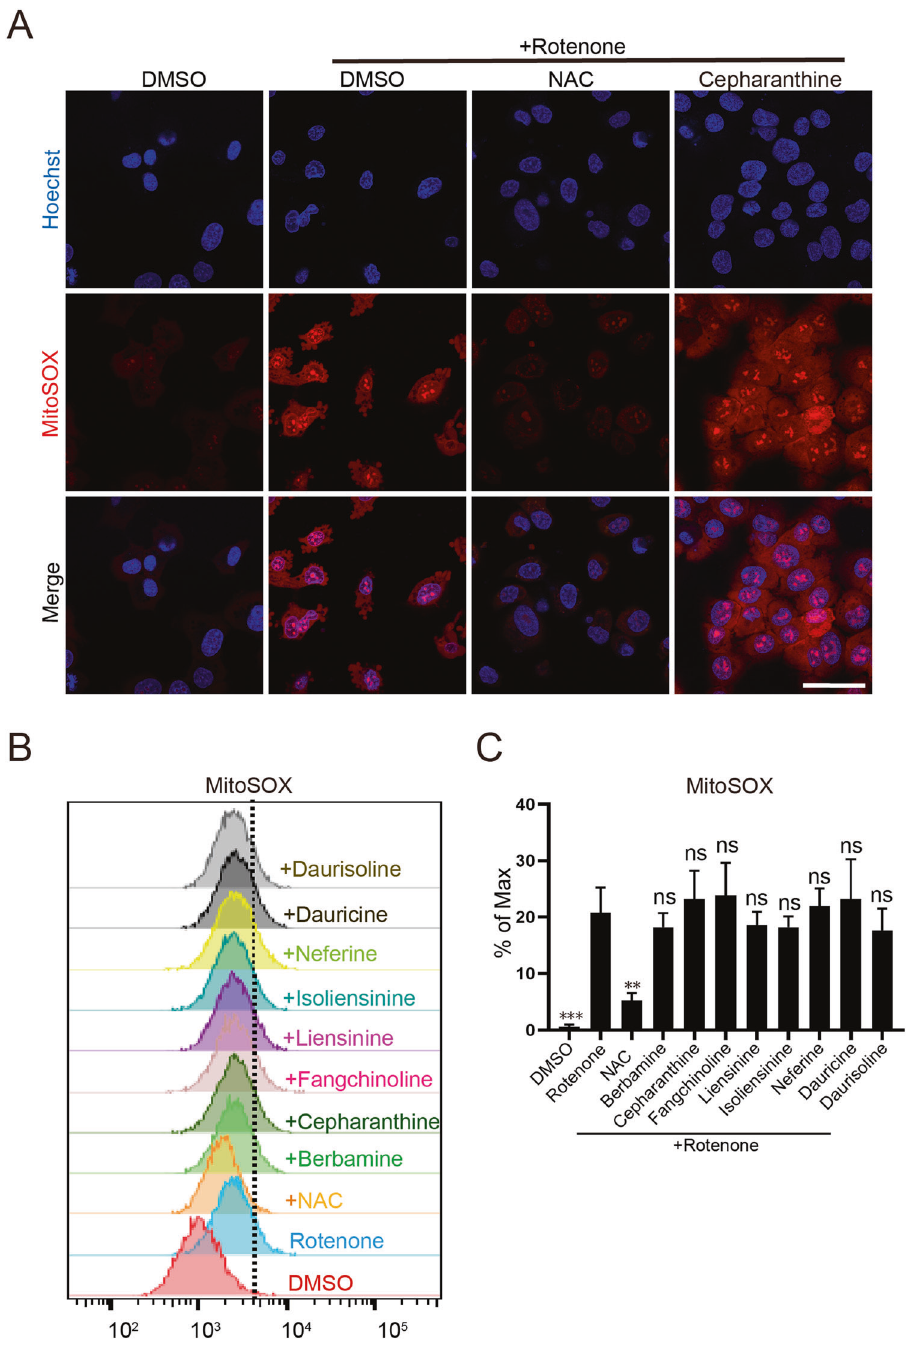
Fig. 4 Analysis of rotenone-induced mitochondrial ROS by MitoSOX staining. A Representative immuno fl uorescence staining of mitochondrial ROS. Cells were treated with rotenone (2 μ M) in the presence of a testing BBIQ compound (5 μ M) or NAC (5 mM) for 4 h, stained with the MitoSOX Red Mitochondrial Superoxide Indicator (5 μ M for 10 min) then analyzed by confocal imaging. Scale bar: 50 μ m. B Flow cytometry analysis of rotenone-induced mitochondrial ROS. C Statistical results for ( B ). Data represent mean ± s.d. from three independent repeats and p value (vs. rotenone alone) is determined by ordinary one-way ANOVA with Dunnett ’ s multiple comparisons test. ns, no signi fi cance; **, p < 0.01; ***, p <